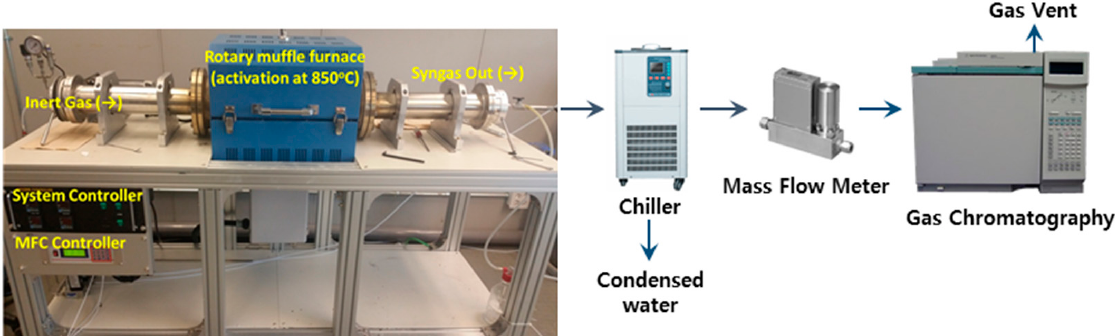
Figure 1. Photo images of chemical activator and gas flow measuring system.